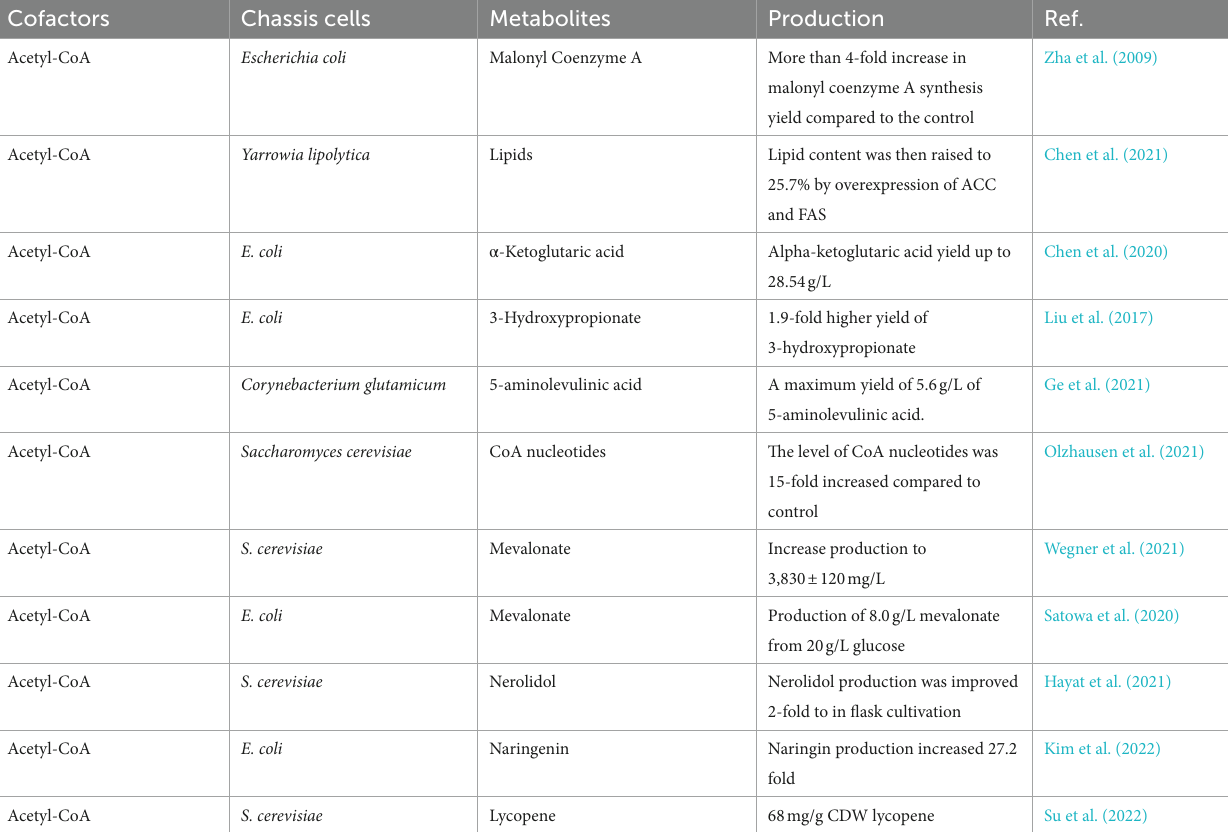
TABLE 1 Acetyl-CoA regulatory